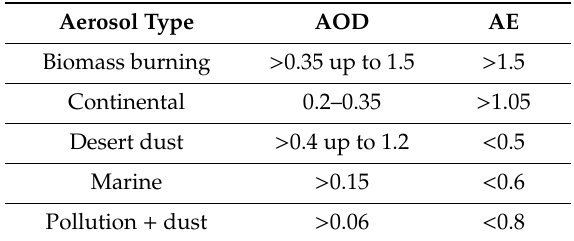
Table 1. Characterization of aerosol type by combination of Aerosol Optical Depth and Angstrom Exponent according to